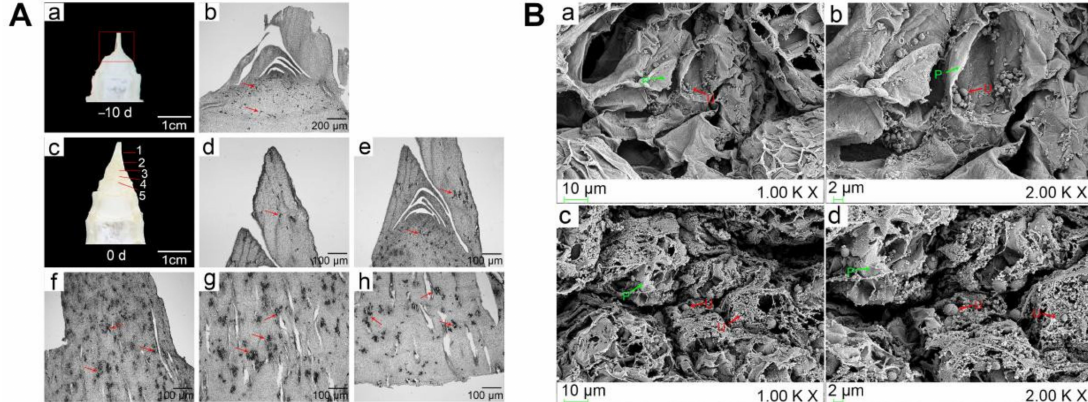
Figure 2. Observation of U. esculenta hyphal distribution in Z. latifolia tissue. ( A ) Paraffin sections showing the U. esculenta hyphal distribution in Z. latifolia stem apexes. ( a , b ). Longitudinal sections of the stem apex ( a ) and U. esculenta hyphal distribution ( b ) at − 10 d before the stem began swelling ( − 10 d), bar = 200 µ m. ( c ). Five tissue parts of the initial swollen stem tissue (0 d). ( d – h ). Distribution of U. esculenta hyphae. 1, ( d ) stem apex, 2, ( e ) first node, 3, ( f ) second node, 4, ( g ) internode, and 5, ( h ) bottom, respectively. bar = 100 µ m. red arrows, U. esculenta . ( B ) Scanning electron micrographs of U. esculenta hyphae in Z. latifolia tissue. ( a , b ) − 10 d before stem-gall formation. ( c , d ) 0 d of the initial stage of stem-gall formation. ( a , c ) and ( b , d ) bar = 10 µ m and 2 µ m. Red and green arrows represent U. esculenta and Z. latifolia tissue, respectively. Green letters P, Z. latifolia ; red letters U, U. esculenta